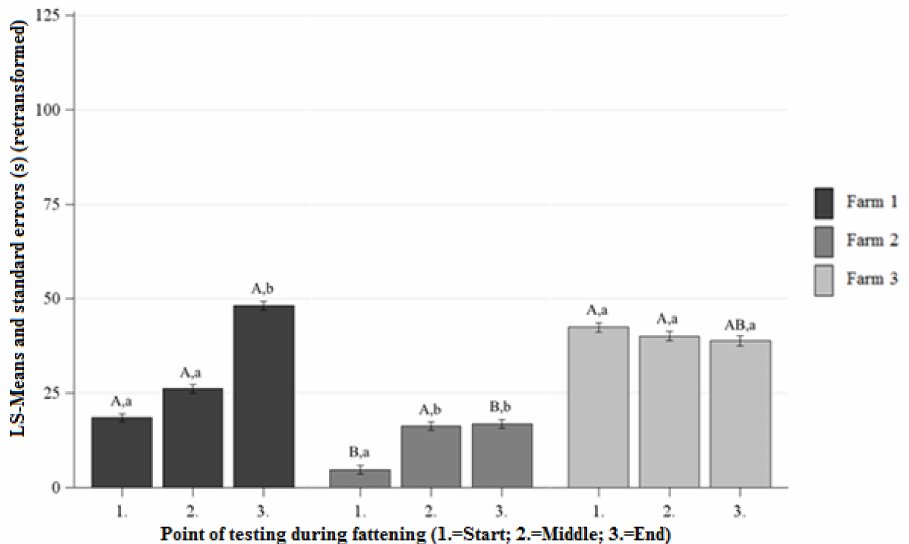
Figure 4. Least squaresmeans and standard errors (in seconds) (retransformed) of the duration of contact in the NOT at each point of testing; a, b, c indicate significant di ff erences within the farm between the di ff erent points of testing ( p < 0.05); A, B, C letters indicate significant di ff erences between the farms within the di ff erent points of testing ( p <